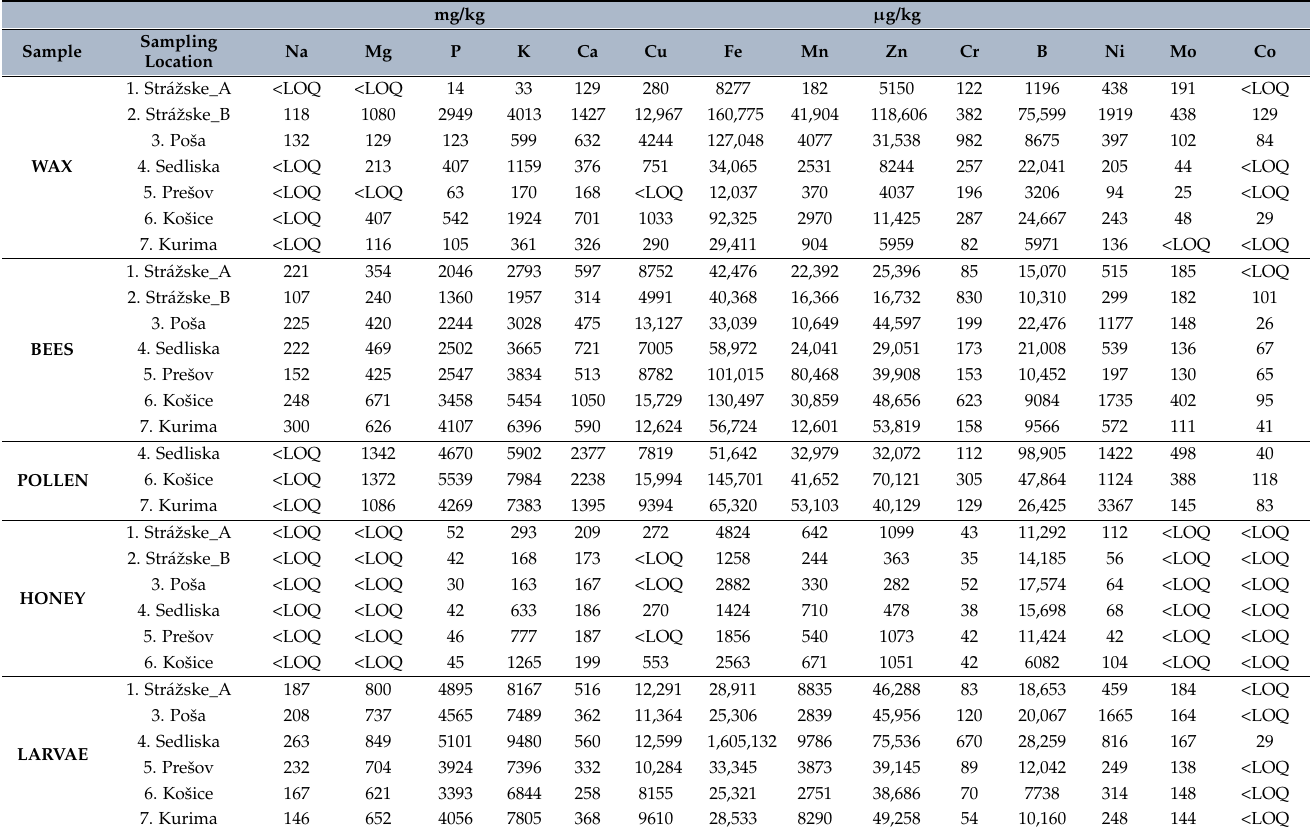
Table 3. Content of essential macro (mg/kg) and trace ( µ g/kg)